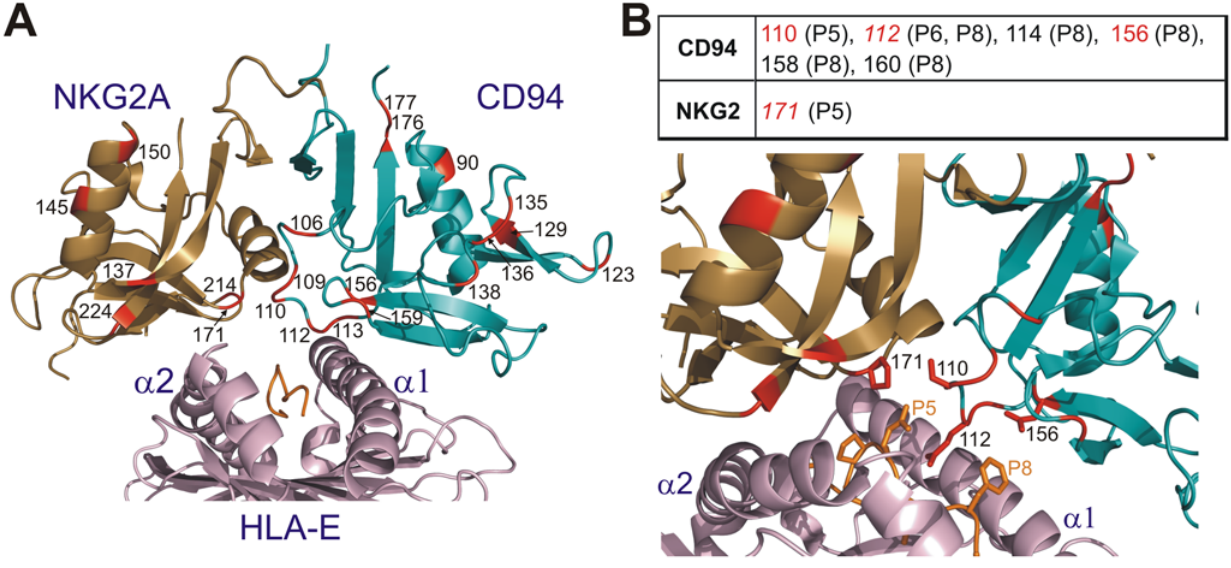
Figure 5. Natural selection diversified ‘‘lower’’ primate CD94 and NKG2 sequences and particularly targeted the residues interacting with the peptide presented by MHC class I ligands. (A) Positively selected sites of ‘lower’ primates CD94/NKG2 superimposed on the three-dimensional structure of the human CD94/NKG2A/HLA-E complex [22,23]. The PDB file 3cdg was used and represented with PyMOL [45]. (B) Top panel: CD94/NKG2 residues known to interact with MHC class I-bound peptide (based on human CD94/NKG2A/HLA-E). Positively selected residues in ‘lower’ primates are shown in red. Peptide positions are indicated. Residue in italics indicates allelic substitutions were found at this site. Bottom panel: ribbon diagram focused on the region where the interaction between CD94-NKG2A and HLA-E occurs; side chains are displayed.